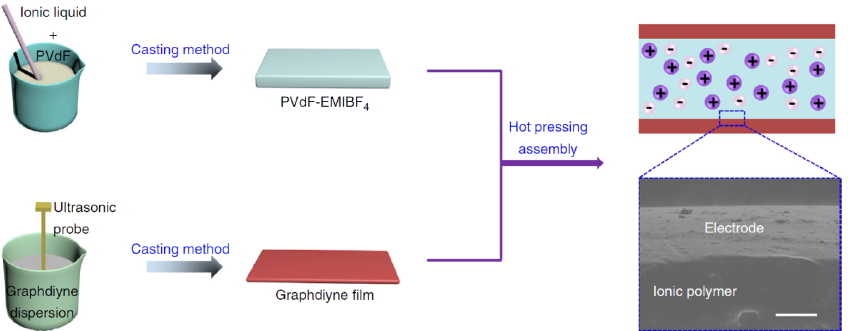
Figure 20. Schematic for the manufacture of graphdiyne electrodes, an electrolyte-containing membrane, and an actuator membrane as a whole. Reproduced from [49] with permission from Springer Nature. Copyright 2018.